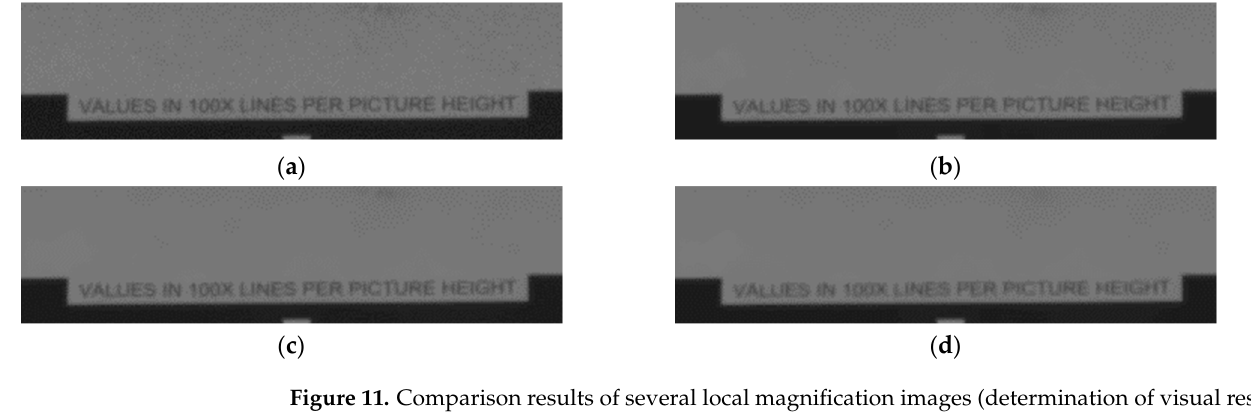
Figure 11. Comparison results of several local magnification images (determination of visual reso- lution): ( a ) local magnification of original laser image with speckle noise; ( b ) local magnification of non-local mean filter image; ( c ) local magnification of improved non-local mean filter image; ( d ) local magnification of improved weighted non-local mean filter image.